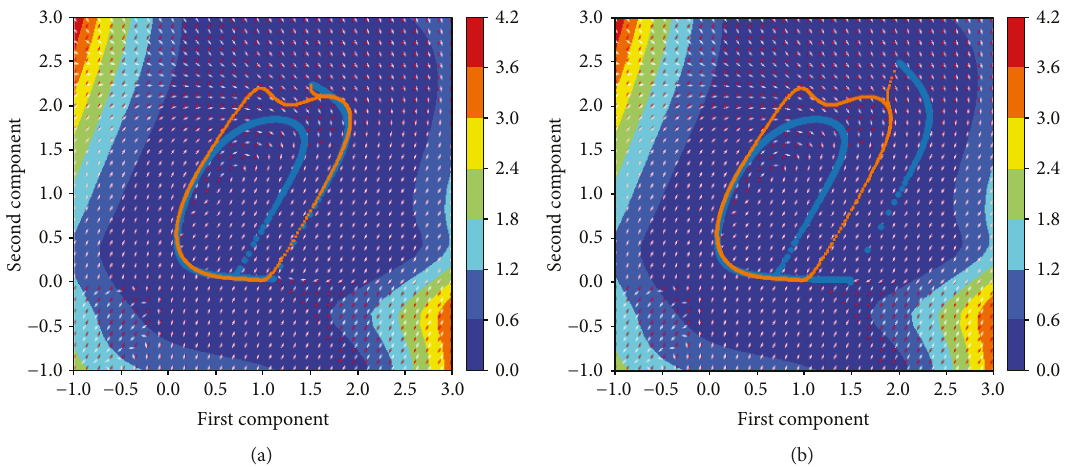
Figure 12: Stepwise error contour of SINDy on nonrational nonpolynomial case. (a) Training data. (b) Testing data. Blue dot: ground truth. Orange dot: prediction. White arrow: direction of target vector of ground truth. Red arrow: direction of target vector of